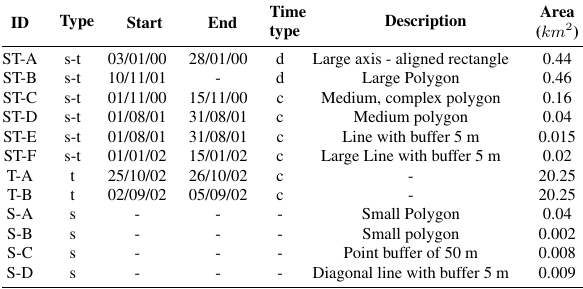
Table 3: The description of the queries. In type : s-t stands for space - time, t for time and s for space. In time type : c stands for continuous and d for